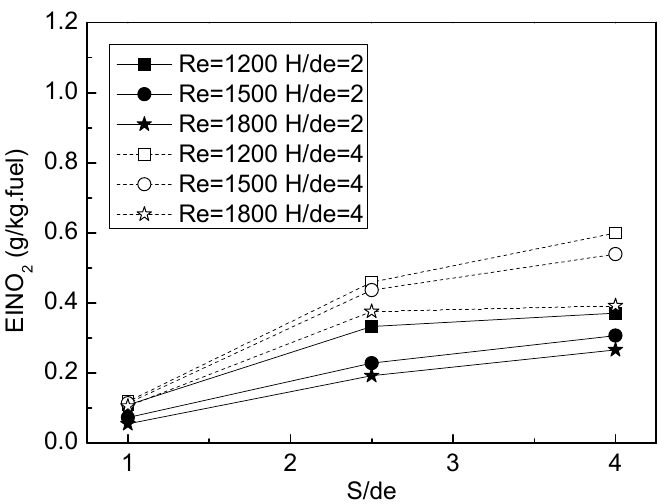
Figure 8. EINO 2 of slot LPG premixed flame array at different conditions.